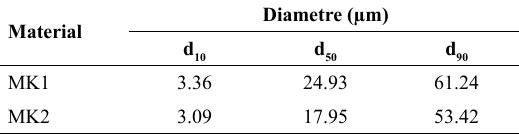
Table 2. Granulometric distribution of metakaolins.